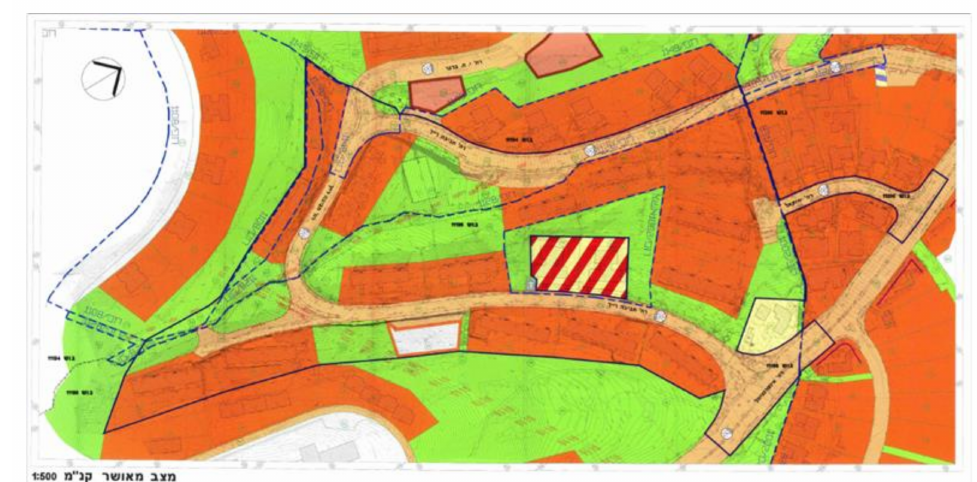
Figure 4. The approved plan. The renewal plan approved in 2003 (note the change in the north direction). Many public spaces between the buildings are now redefined as residential areas (in orange). The planners are Giora Gur Architects. Source: the Israeli “Available Planning” website (The Planning Administration, Ministry of Interior)